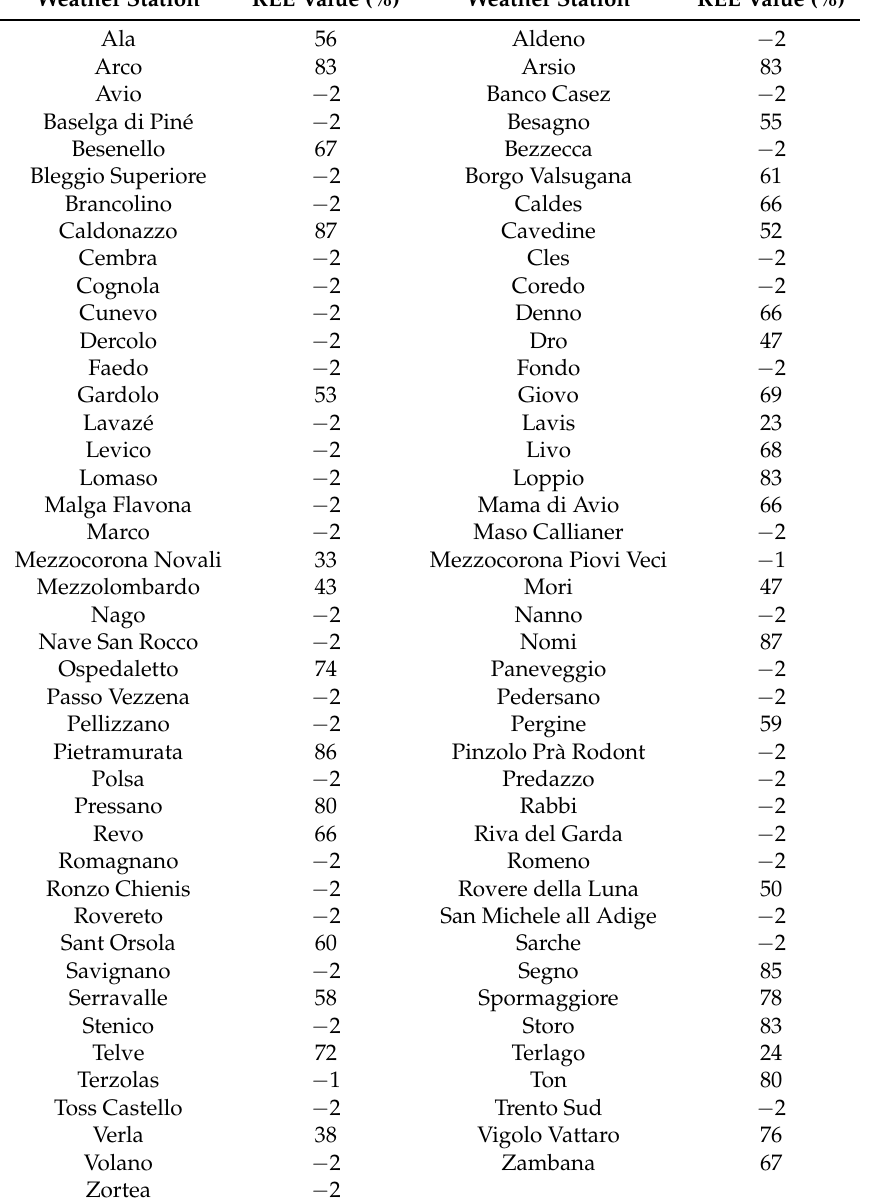
Table 3. Risk Evaluation Error for each of the Edmund Mach Foundation weather stations in 2015. Risk Evaluation Error values of − 1 means that no risk of infection has been computed, Risk Evaluation Error values of − 2 correspond to missing weather values for Leaf Wetness